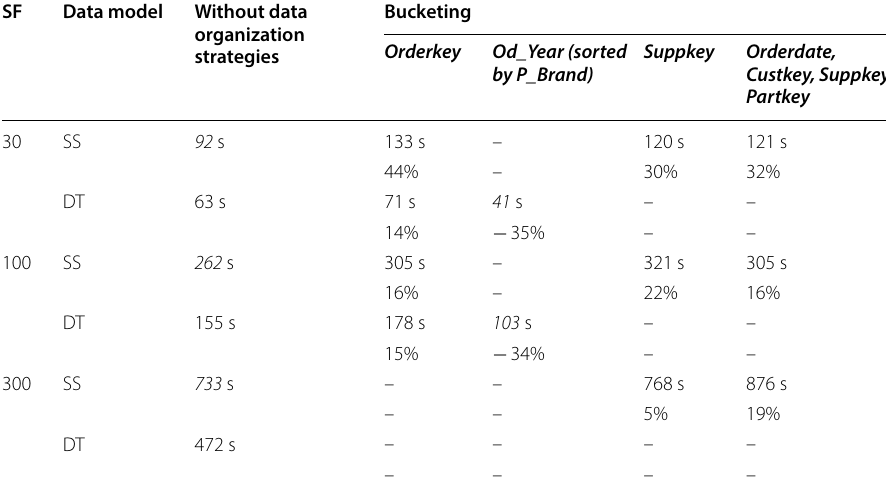
Italic values indicate the fastest processing time by SF, data model and